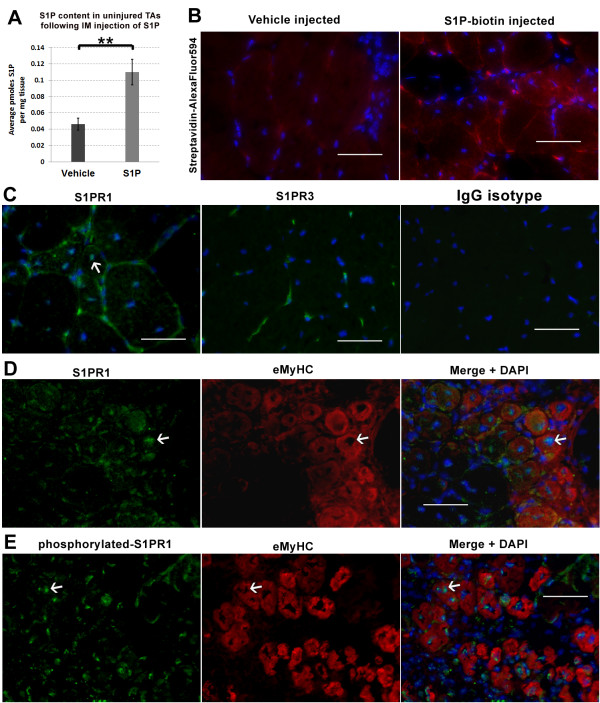
Direct injection results in elevated S1P levels which correlate with the activation of receptor 1 in muscle fibers. (A) To quantify the elevation of S1P following direct administration, we injected a single dose (same dose as Figure 5) of S1P in left TAs and vehicle in right TAs of uninjured mdx4cv (n = 3, 11-MO) mice. TA muscles were harvested 15 minutes post injection for analysis by LC-MS/MS. Results indicate a significant elevation of S1P following direct injection. (B) To visualize the location of S1P following injection, biotinylated-S1P was injected in left TAs versus vehicle in right TAs of uninjured mdx4cv mice (n = 2, 11-MO). Once more, TAs were harvested 15 minutes following injection. Staining with streptavidin conjugated to Alexa Fluor 594 reveals the presence of S1P-biotin around the perimeter of muscle fibers. (C) Staining of mdx4cv TAs for S1PR1 and S1PR3 reveals S1PR1 is localized to the perimeter and perinuclear area (arrow) of muscle fibers (left photo). In contrast, staining for S1PR3 was mainly localized to the muscle vasculature (middle photo). Staining in parallel with an IgG isotype control for both antibodies shows the absence of non-specific staining (right graph). (D) Staining for S1PR1 in CTX-injured TAs (same tissue from Figure 5) reveals S1PR1 is present at the perimeter and perinuclear area of regenerating eMyHC+ fibers. (E) Staining for phosphorylated S1PR1 in the same mdx4cv TAs was more prominent in the perinuclear area of eMyHC+ fibers, indicating the presence of active S1PR1 signaling in regenerating fibers. Scale bars = 50 μm. **P <0.005 by student’s t-test. Error bars represent SEM. CTX, cardiotoxin; eMyHC, embryonic myosin heavy chain; IgG, immunoglobulin G; LC-MS/MS, liquid chromatography-tandem mass spectrometry; MO, month-old; S1P, sphingosine-1-phoshate; S1PR1, S1P receptor 1; S1PR3, S1P receptor 3; SEM, standard error of the mean; TA, tibialis anterior.